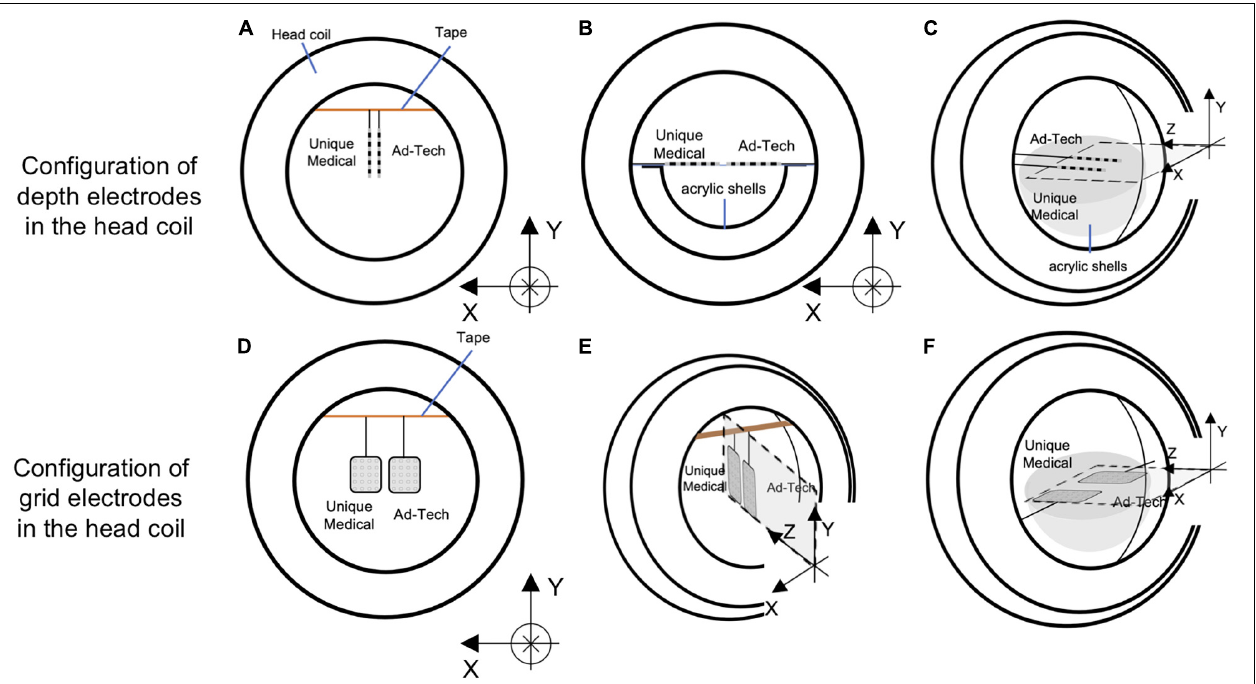
FIGURE 4 | Configurations of the electrodes in the head coil during experiments for detecting gradient switching-induced electrode movement by visual assessment. Configurations of depth electrodes were shown in the upper panel and grid electrodes in the lower panel. Two depth electrodes (one Unique Medical and another Ad-Tech) were placed parallel to the Y -axis (A) , X -axis (B) , or Z -axis (C) . Two grid electrodes (one Unique Medical and another Ad-Tech) were placed in the XY-plane (D) , YZ-plane (E) , or ZX-plane (F) . In (A,D,E) , the electrodes were hanged down from a surgical tape (indicated as orange line) that was placed across the head coil parallel to the X -axis, with the end taped to the head coil. Each electrode was taped to the surgical tape at a point 7.5 cm from the tip. In (B,C,F) , the electrodes were placed on an isometric graph paper attached on the acrylic shell (that was used for preparing the head phantom). In all (A–F) , the electrodes were placed as close as possible to the center of the head coil (without touching each other), which was then placed at the isocenter of the magnetic resonance imaging scanner bore while running scans of EPI sequence.